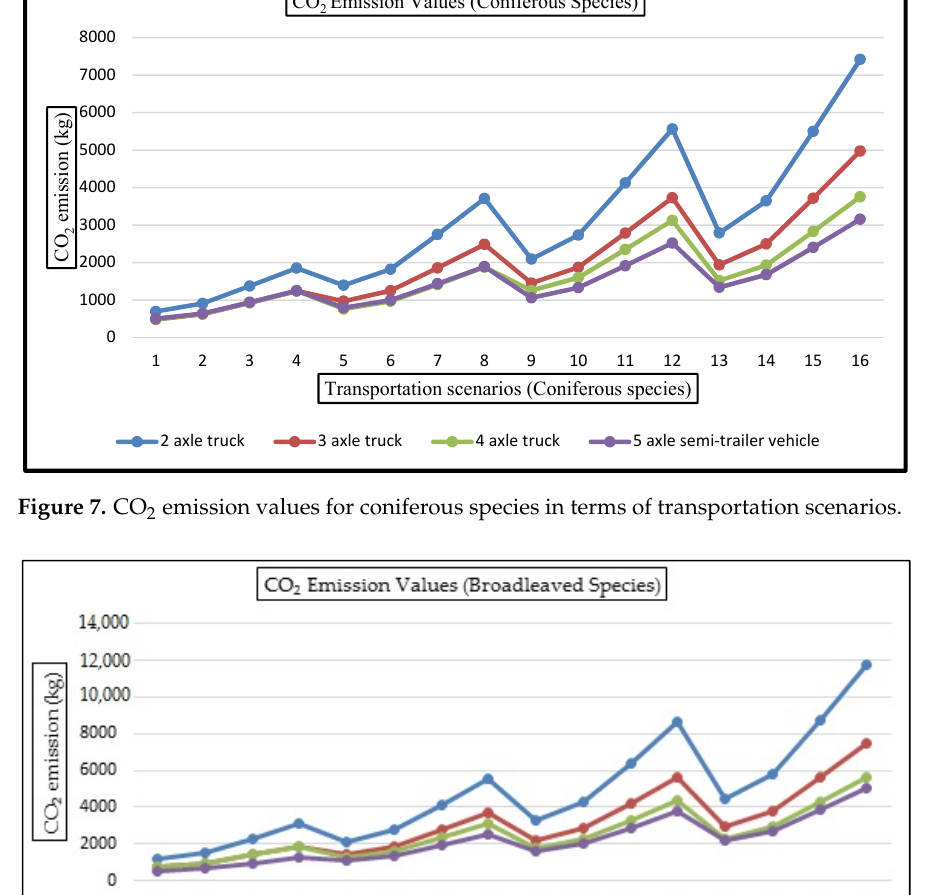
Figure 8. CO 2 emission values for broadleaved species in terms of transportation scenarios. On the other hand, the risk of damage to the road surface (ruts, cracks, deformations, potholes, etc.) depends on the transportation vehicles tare weight and gross weight. Road surface damage risk is obtained as a ratio. For example, in the transportation scenarios created for coniferous tree species, obtaining the road surface damage risk of a 2-axle ve- hicle for the first transportation scenario is given in Equation (28).